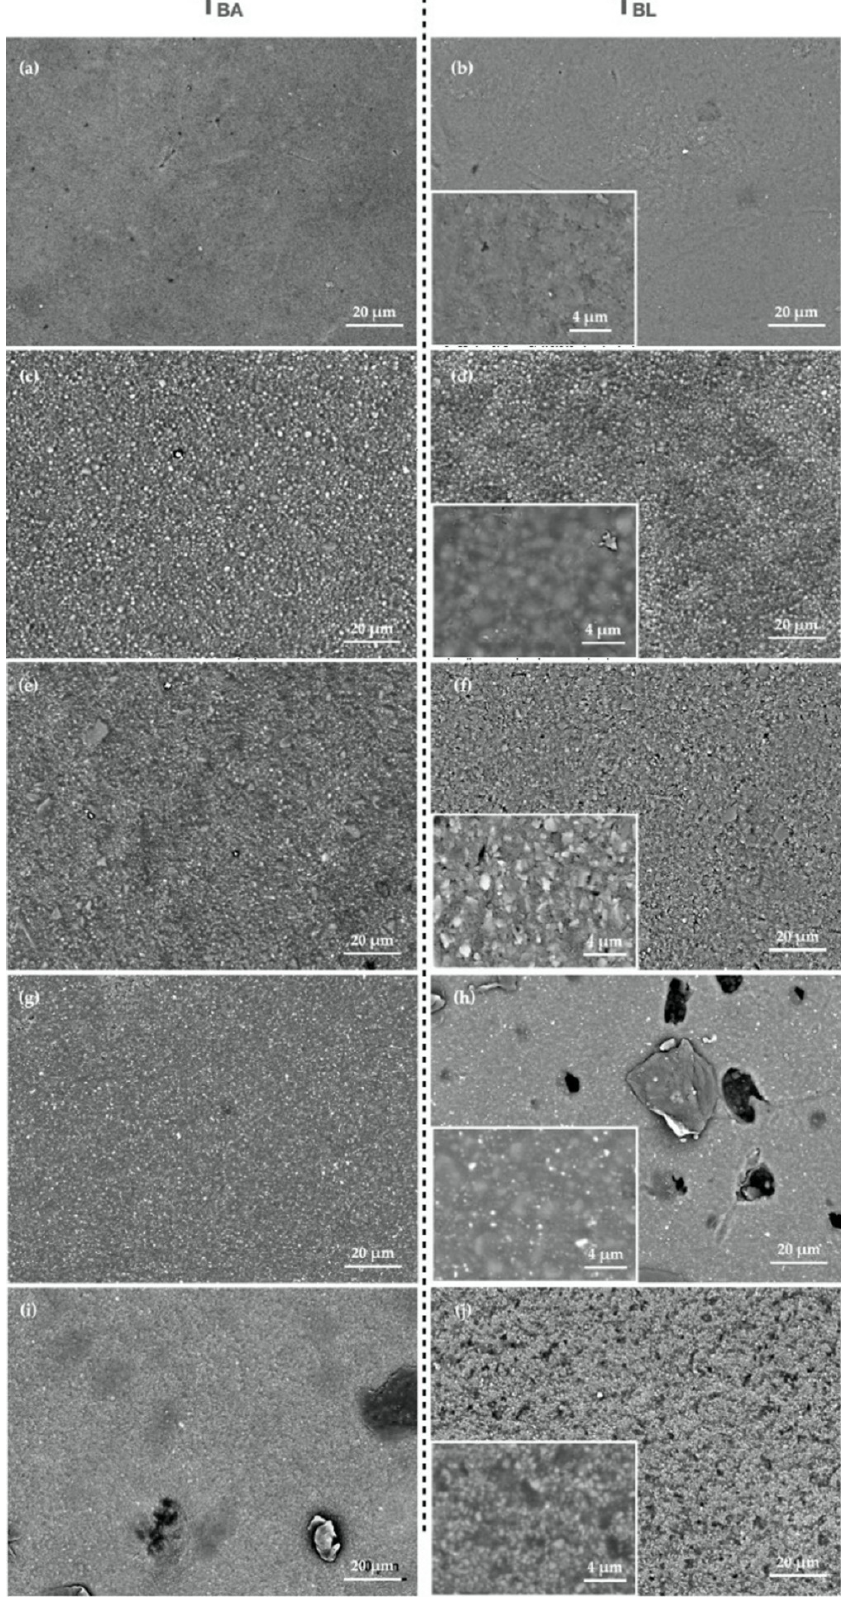
Figure 2. Scanning electron microscope images of ( a , b ) ESQ, ( c , d ) Z350, ( e , f ) GRA, ( g , h ) BFP, and ( i , j ) OPT before (T BA ) and after (T BL ) bleaching. The insert picture shows a SEM image of the specimen surface at high magnification at T BL .